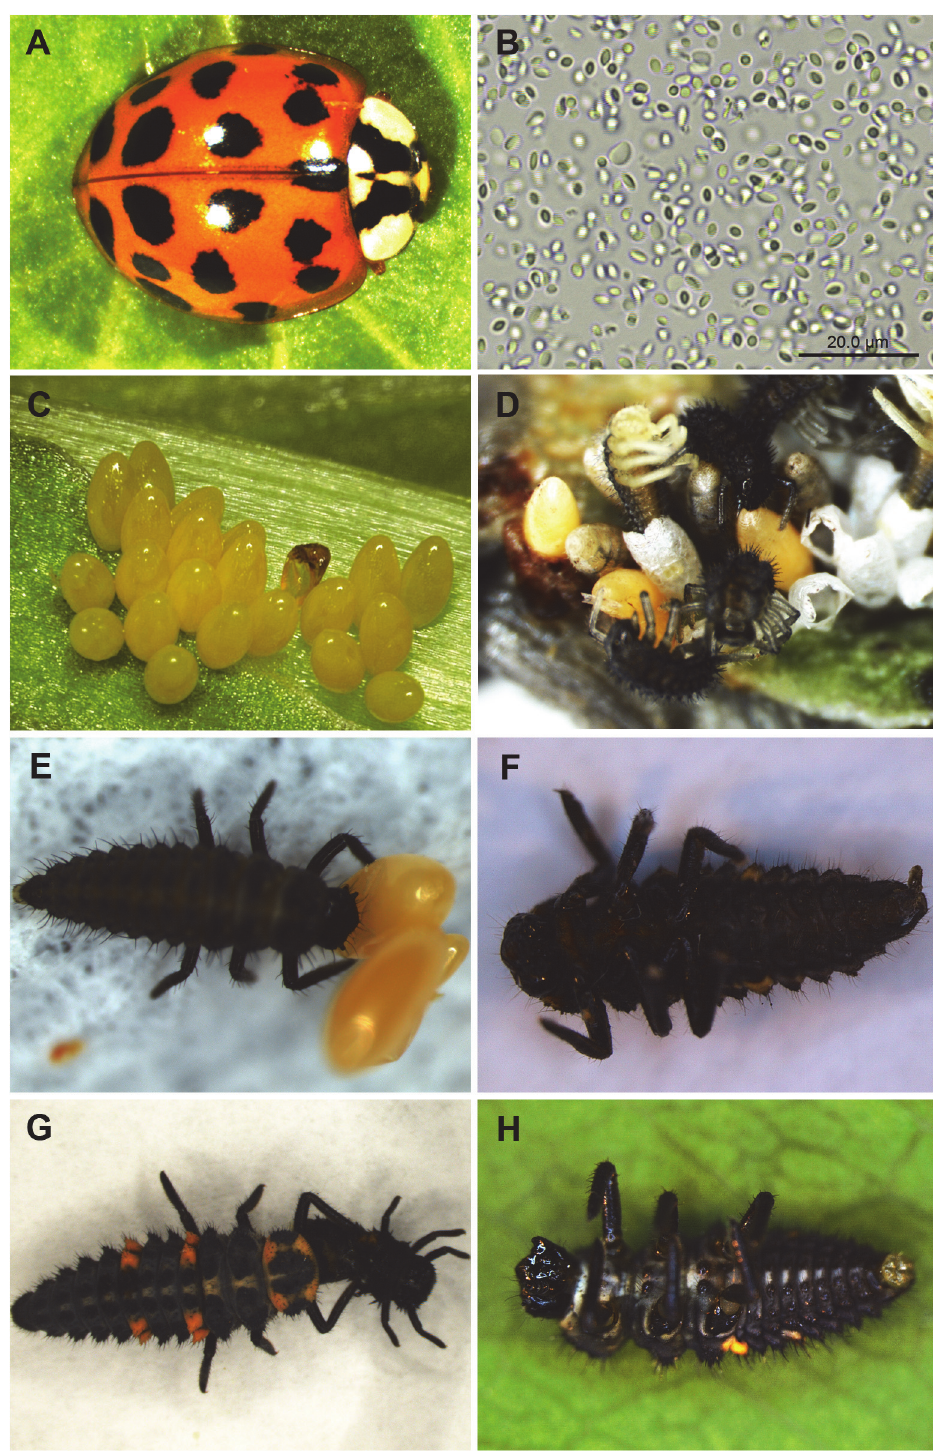
Fig 1. Transmission of pathogens from invasive to native ladybirds. The invasive ladybird H . axyridis (A) carries a high load of microsporidia in its hemolymph (B), and these parasites are vertically transmitted via the eggs (C) and larvae (D). Native predatory ladybird species such as the larvae of the two-spotted ladybird Adalia bipunctata , which feed H . axyridis eggs, can become infected via the oral uptake of microsporidia (E) and ultimately die (F). Similarly, larvae of the native seven-spotted ladybird C . septempunctata are known